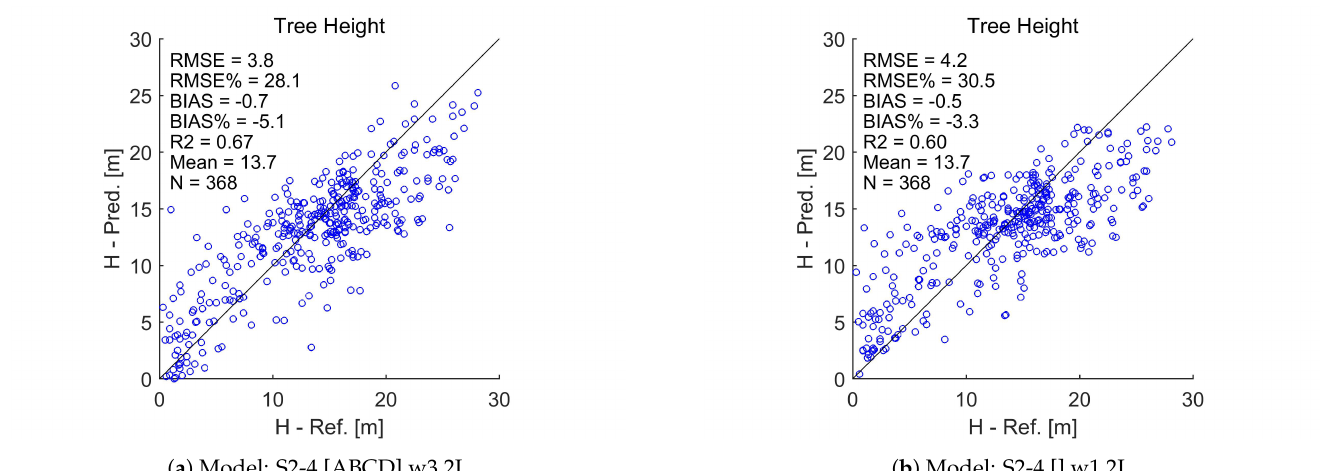
Figure A3. Scatterplots of tree height (H) test data set predictions with the proposed model concept ( a ) and with the simple model ( b